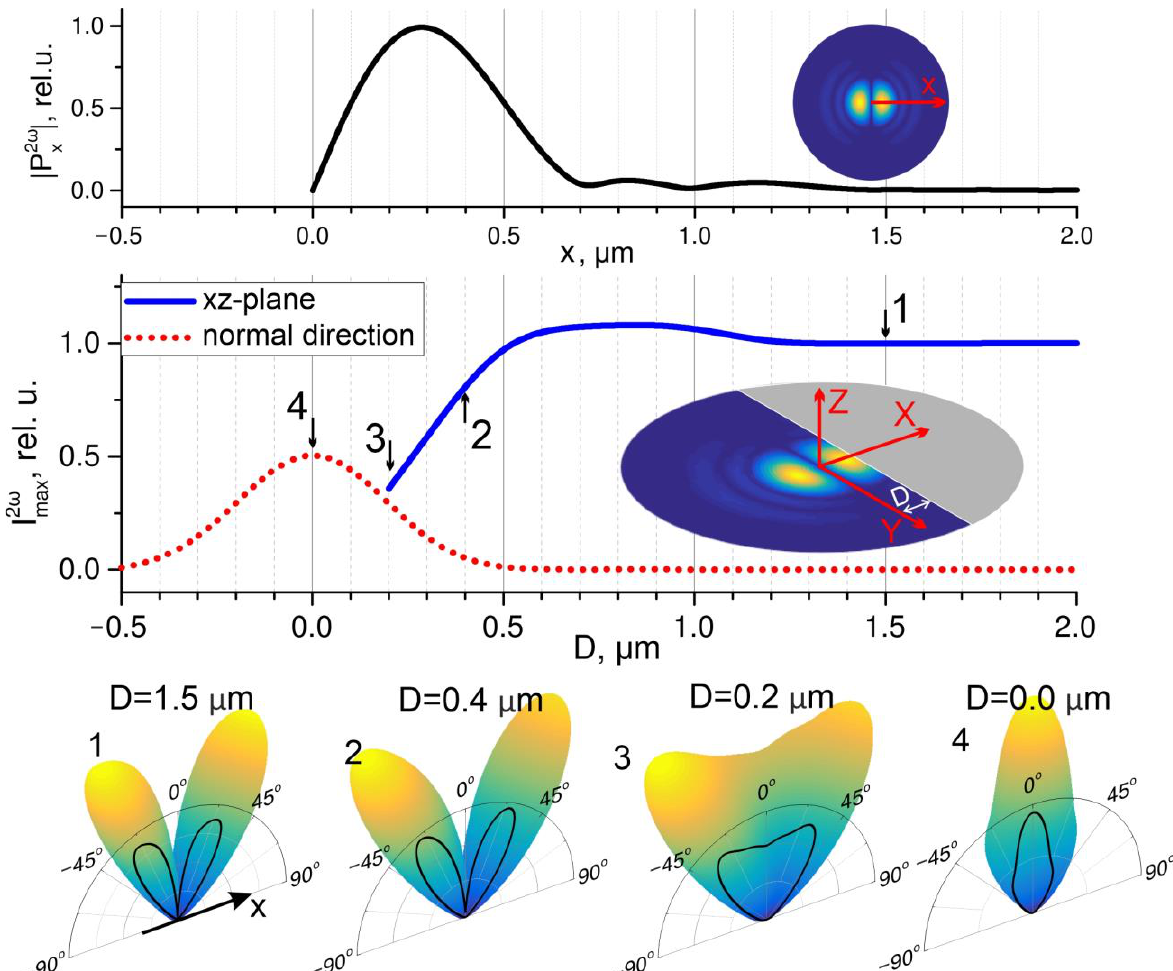
Figure 6. ( Upper row ): x -profile of distribution of nonlinear polarization (| P x 2 ω |) at the surface possessing χ (2)xzx -component of second-order susceptibility excited by a linearly x -polarized beam; inset: 2D-map of polarization. ( Middle row ): maxima of the intensity of the SH radiation in the xz -plane (solid curve) and the intensity in the normal direction (dotted curve) vs. distance between the beam center and the edge of the nonlinear region ( D ); the axis and D are designated in the inset; negative D corresponds to the beam center falling over the edge. ( Lower row ): second harmonic radiation patterns for D = 1 .5 μm (1), D = 0 .4 μm (2), D = 0 .2 μm (3) and D = 0 .0 μm (4); overlaying curves: cross-sections of RPs in the xz -plane.